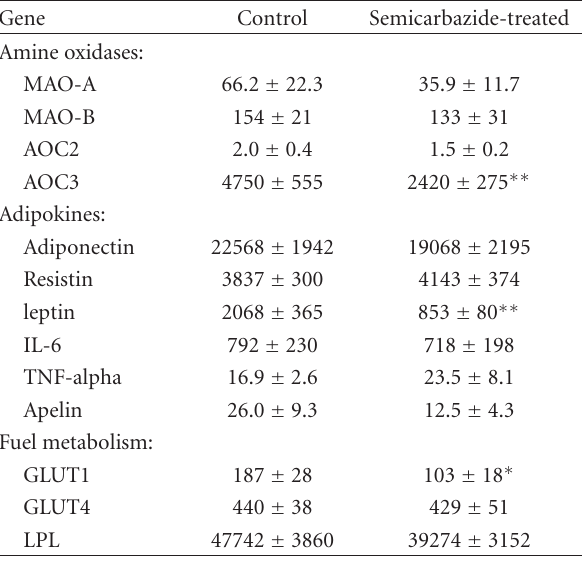
Table 2: Gene expression in visceral adipocytes from semi- carbazide-drinking or control